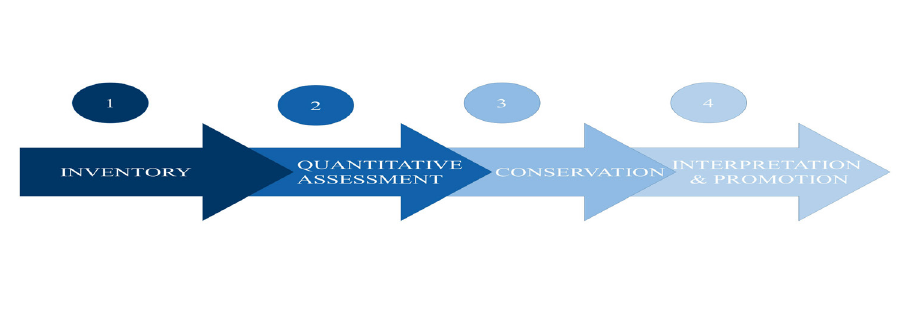
Figure 11. Various steps to establishing geoheritage